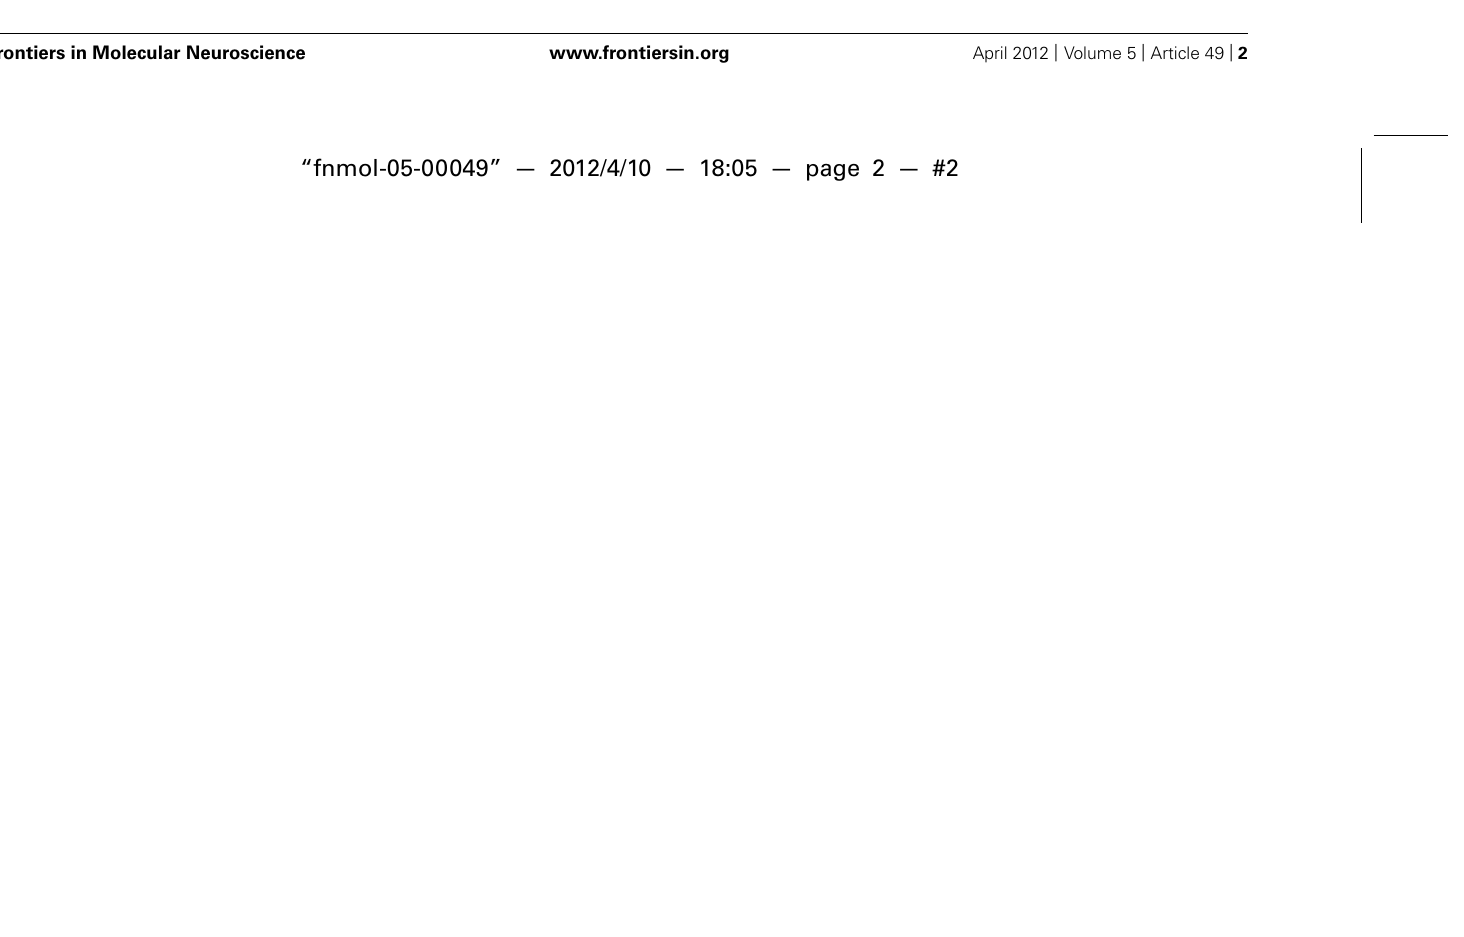
FIGURE 1 |The role of CP-AMPARs in neuronal plasticity. GluA2-lacking receptors are relatively rare at baseline conditions in most excitatory neurons. However, GluA1/2 heteromers are replaced with GluA1 homomers after the induction of numerous plasticity paradigms. Since GluA1 homomers conduct Na + and Ca 2 + ions, synaptic transmission is usually potentiated even if the absolute numbers of receptors are the same. Precisely how this AMPAR subunit switch or replacement takes place is unclear. In some cases homomers may be directly inserted without replacing heteromers, which